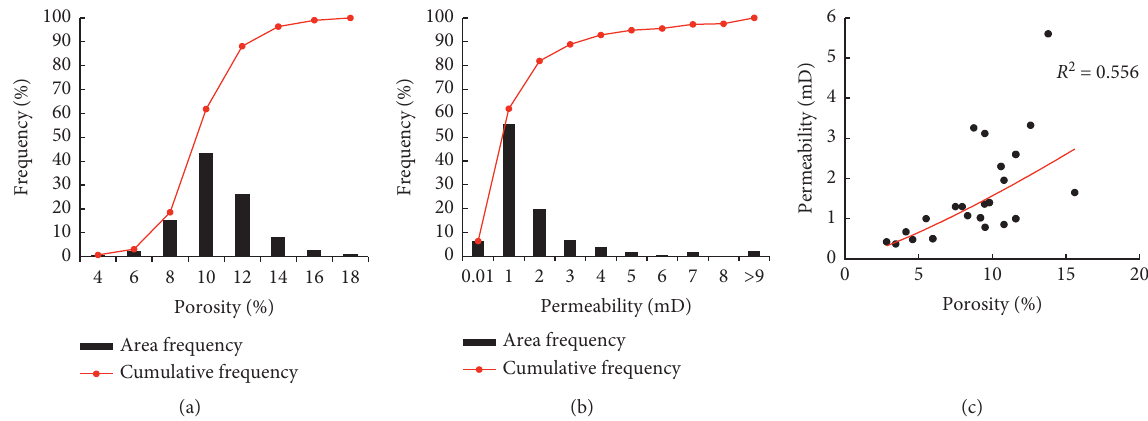
Figure 4: The distribution of (a) porosity, (b) permeability, and (c) the porosity-permeability relationship of Chang 2 reservoir in the study